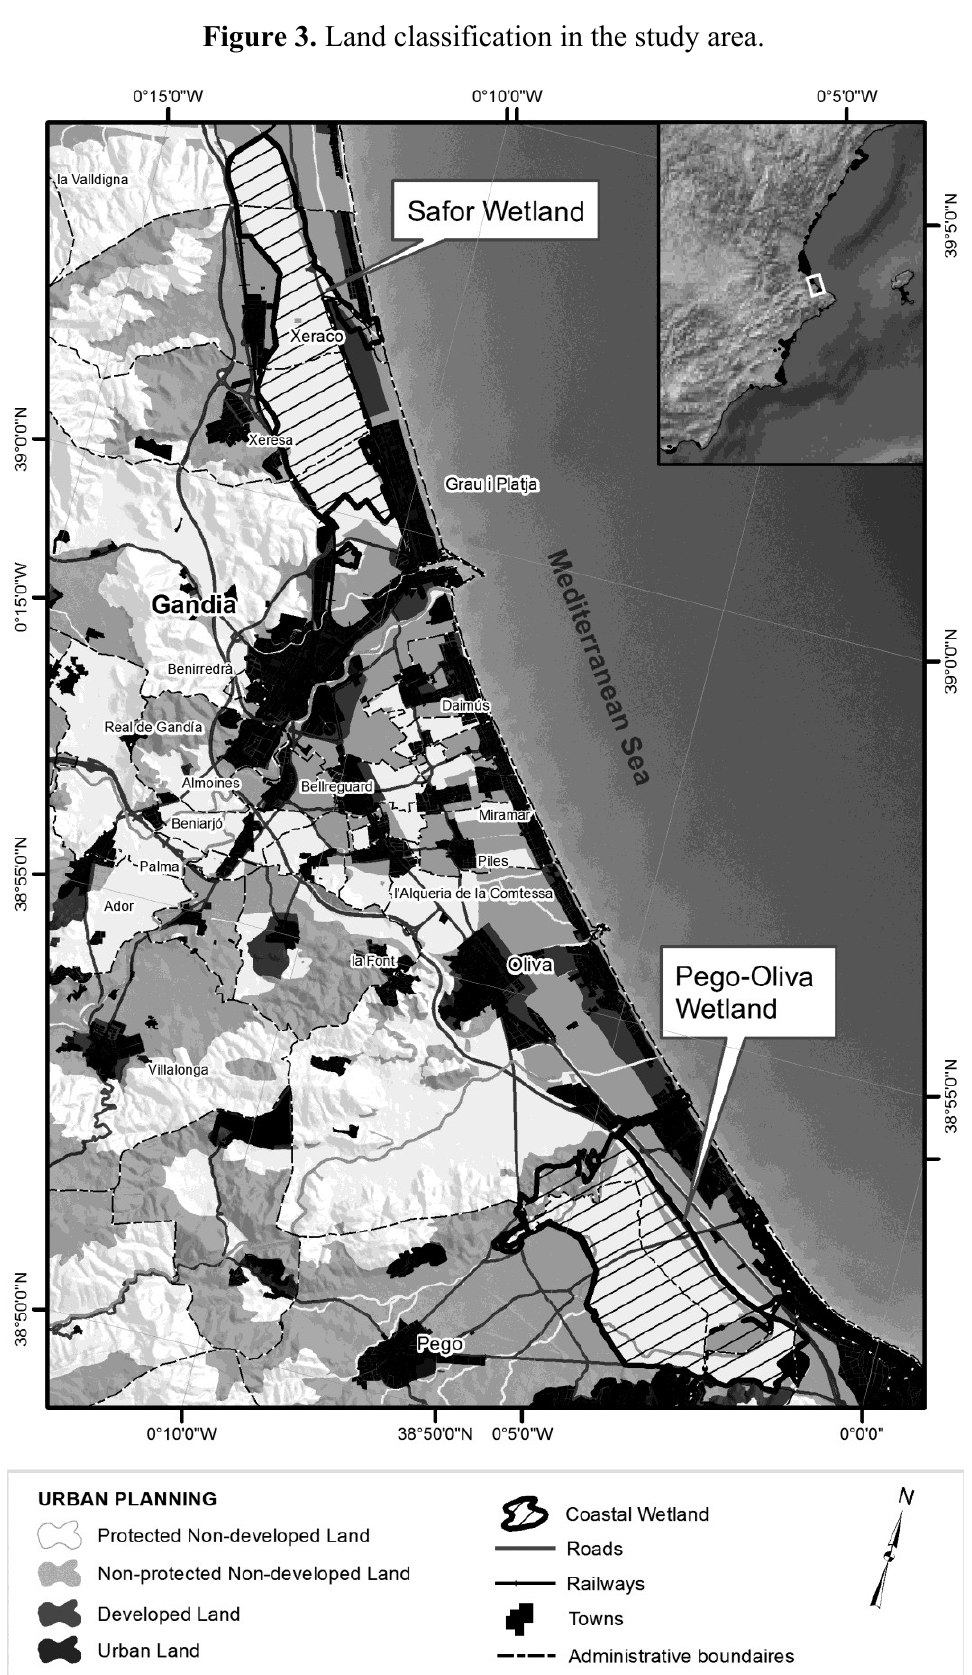
Figure 3. Land classification in the study